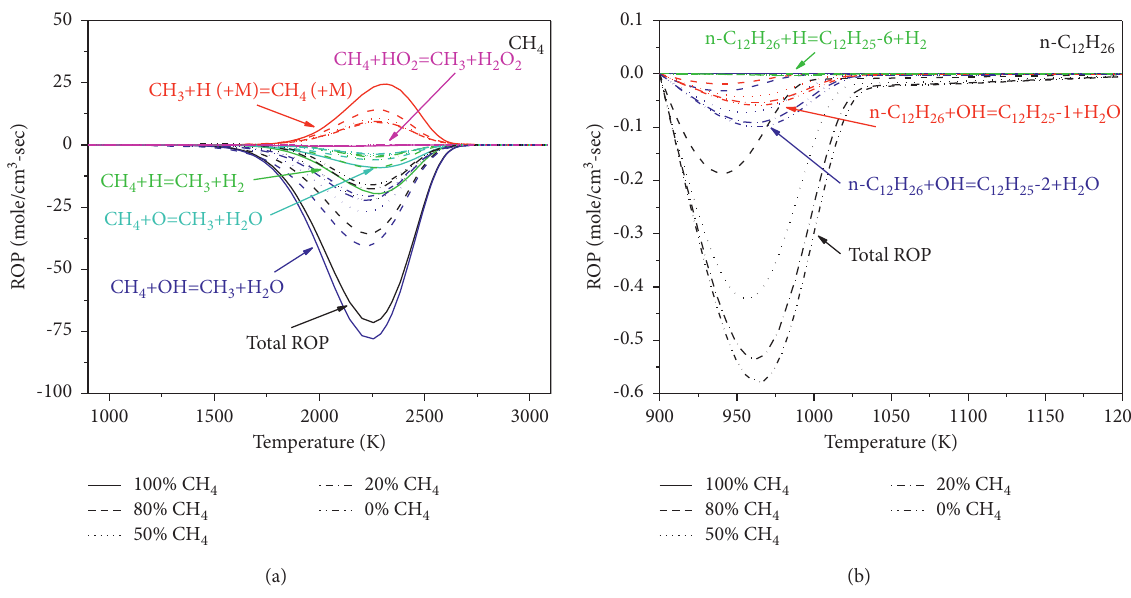
Figure 15: Rates of production and consumption for CH dodecane mixing